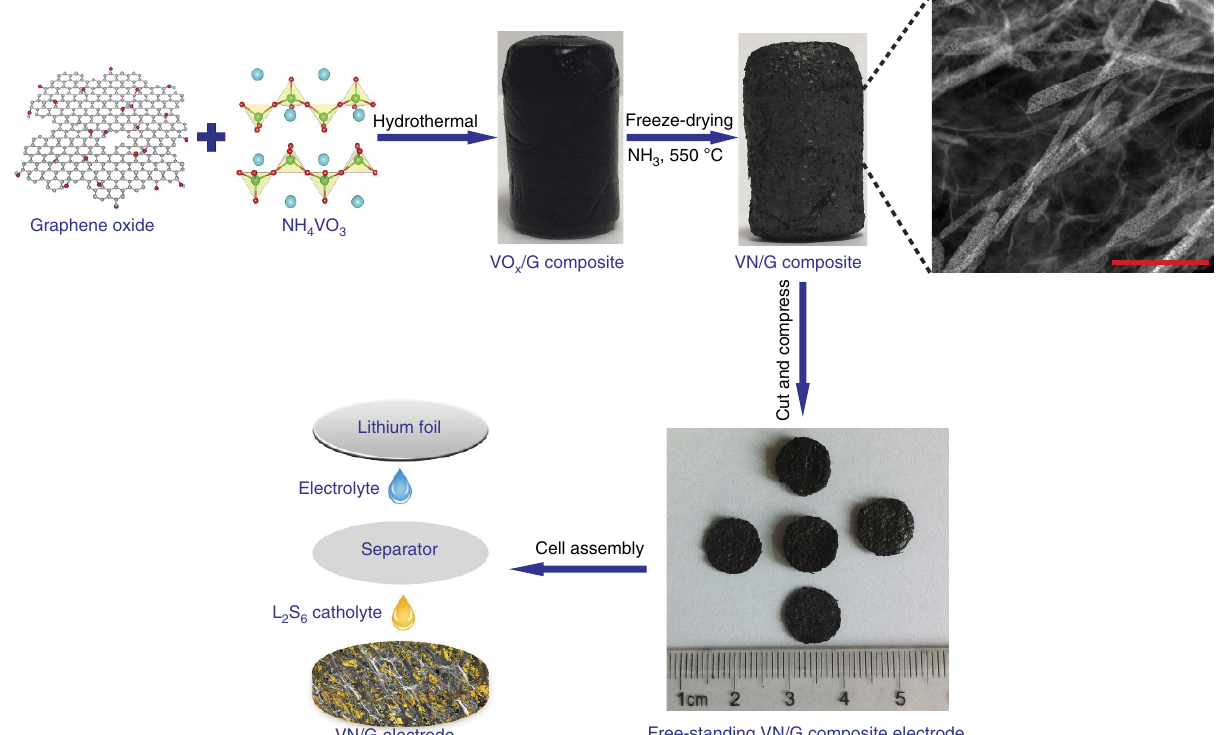
Figure 1 | Schematic of fabrication process of VN/G composite and cell assembly. Schematic of the fabrication of a porous VN/G composite and the cell assembly with corresponding optical images of the material obtained. Scale bar,